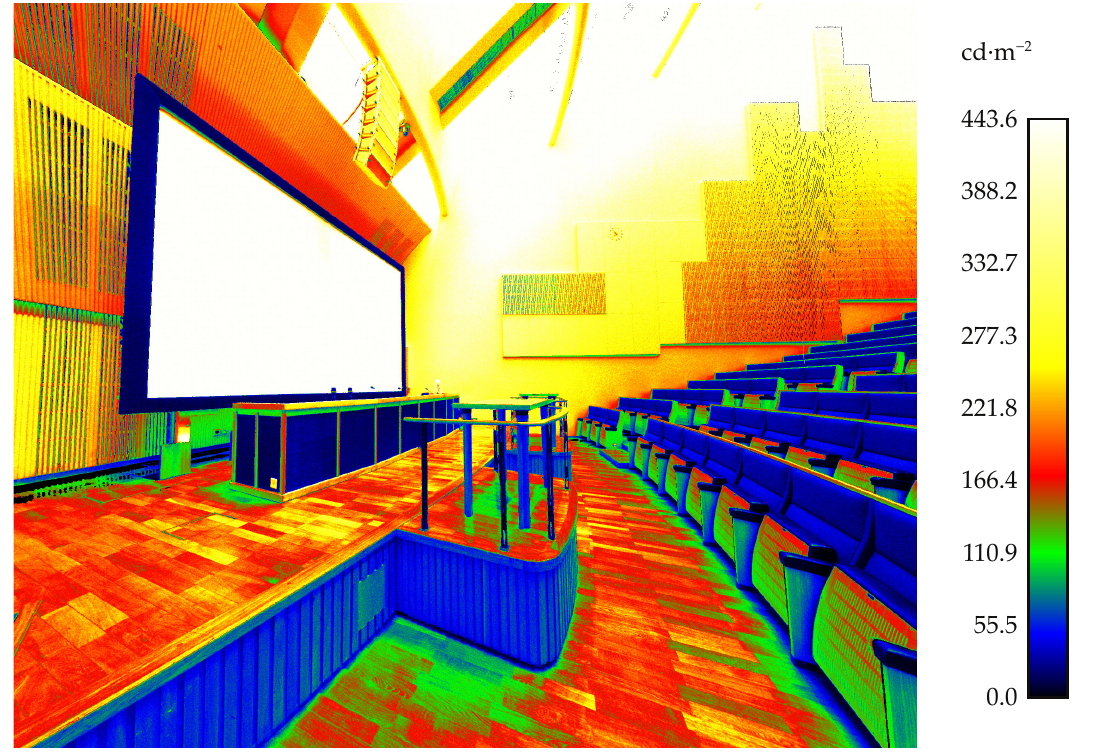
Figure 11. The luminance point cloud of scanning station 2.